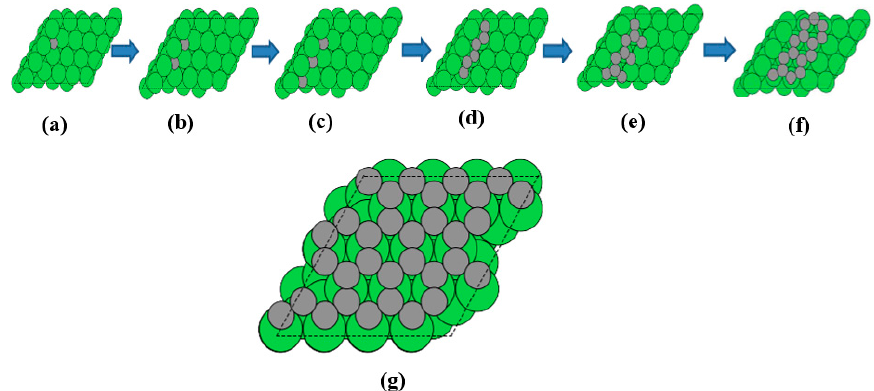
Figure 2. Sequential adsorption of carbon monomers for the nucleation of monomeric species on the step hollow site ( a – c ) and the growth of polymeric species as linear ( d ), branched ( e ), and hexagonal ring ( f ) species. Polymeric carbon laydown modelled as an adsorption graphene overlayer on the Ni(111) surface ( g ).